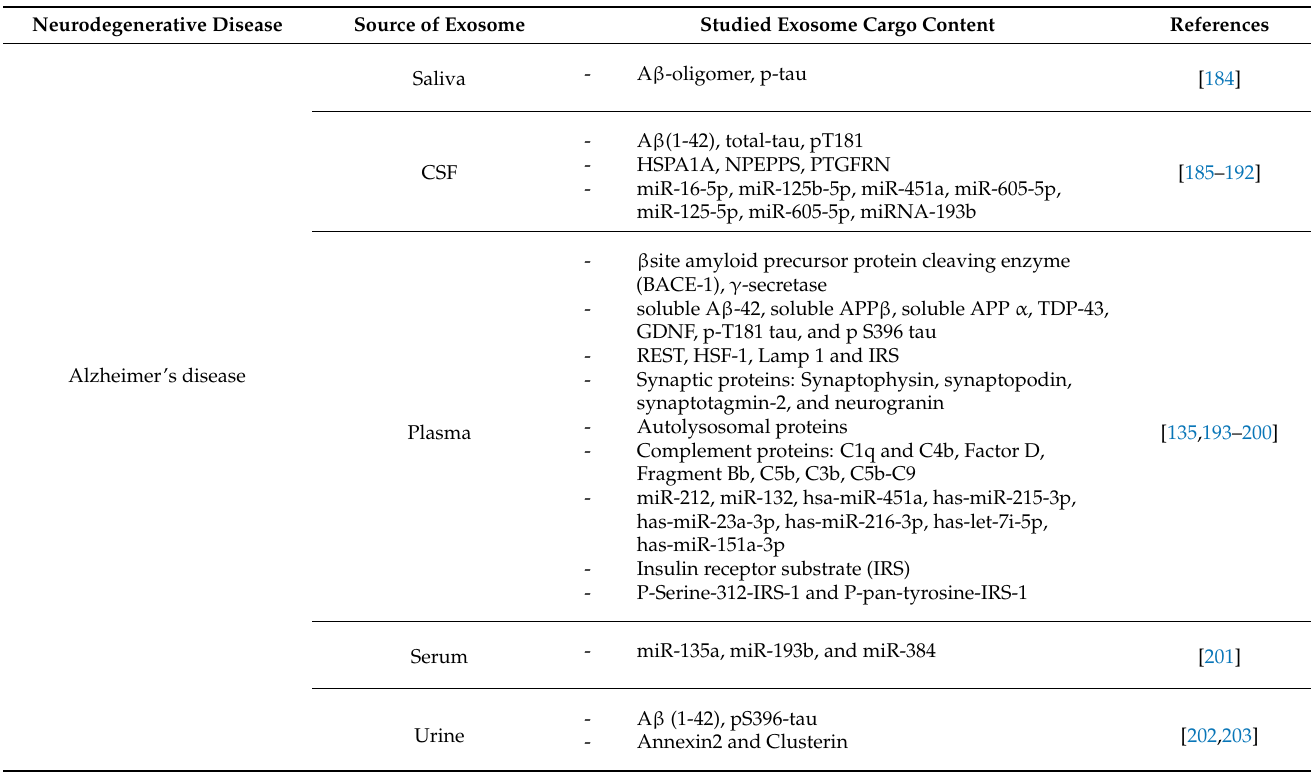
Table 3. Studies describing the potential role of exosomes as an early diagnostics for neurodegenerative diseases. (“__” signifies no studies are reported in this